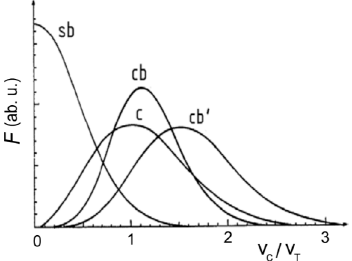
Figure 10. Distribution function F in a single beam (sb), crossed beams (cb), counter beams (cb’), and gas cell (c).